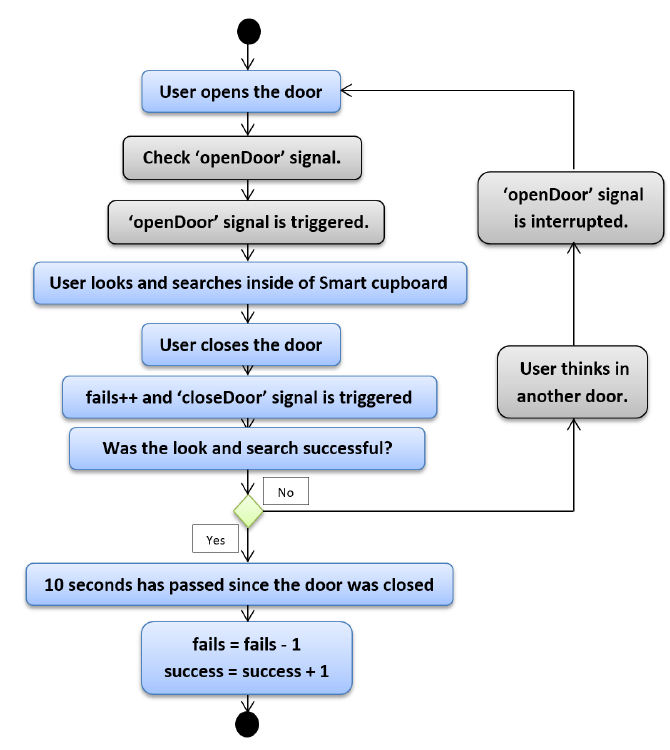
Figure 5. Python script—Second